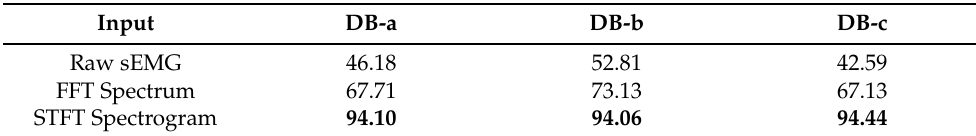
Table 1. Traditional supervised learning classification accuracy (%) of different input forms on CapgMyo (18 subjects and 8 gestures for DB-a, 10 subjects and 8 gestures for DB-b, 10 subjects and 12 gestures for DB-c). The boldface numbers represent the best classification accuracies for each